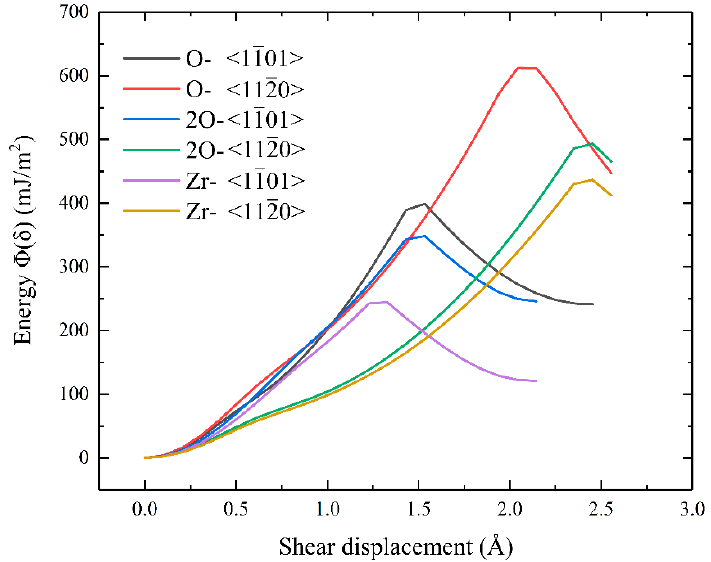
Figure 3. The energy Φ as a function of the shear displacement δ of the c-ZrO 2 (001)/ α -Al 2 O 3 (1102) interface models.